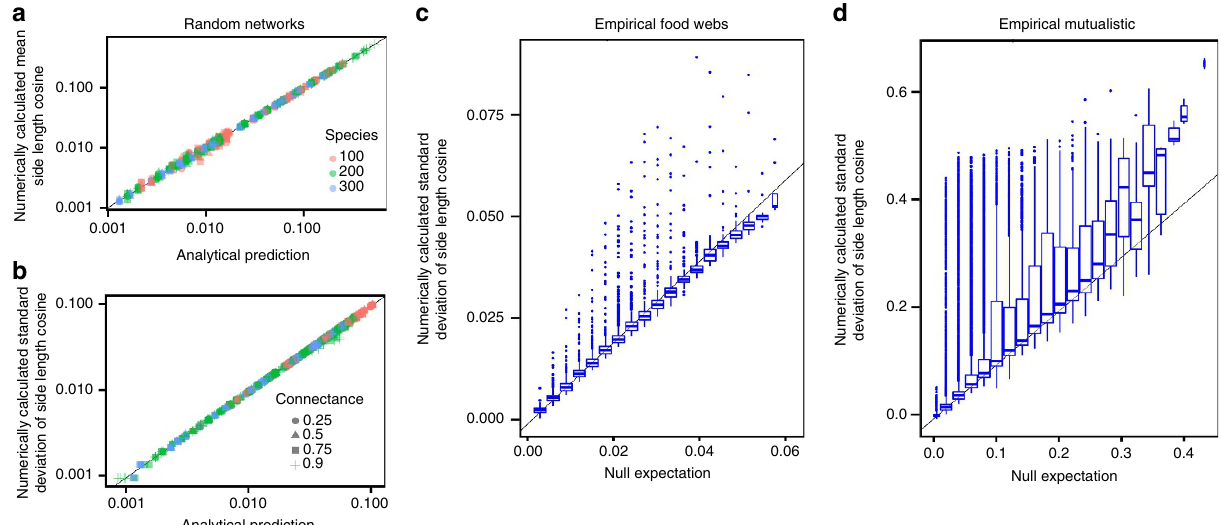
Figure 3 | Distribution of side lengths in random and empirical networks. Left panels show the mean ( a ) and the s.d. ( b ) of cos( Z ), where Z is the side length. Analytical predictions for the first two moments of cos( Z ) (Supplementary Note 10) perfectly match the numerical simulations. The two panels on the right show the s.d. of cos( Z ) for food webs ( c ) and mutualistic networks ( d ) compared with the expectations for the randomized cases. Both trophic and mutualistic interactions show larger fluctuations of side lengths, suggesting the existence of perturbation directions to which the system is more sensitive than to others. This effect is particularly pronounced and relevant for mutualistic networks. While mutualistic and random networks have a similar feasibility domain size X , this result implies that the response of mutualistic networks to perturbations is in fact more heterogeneous than those of their random